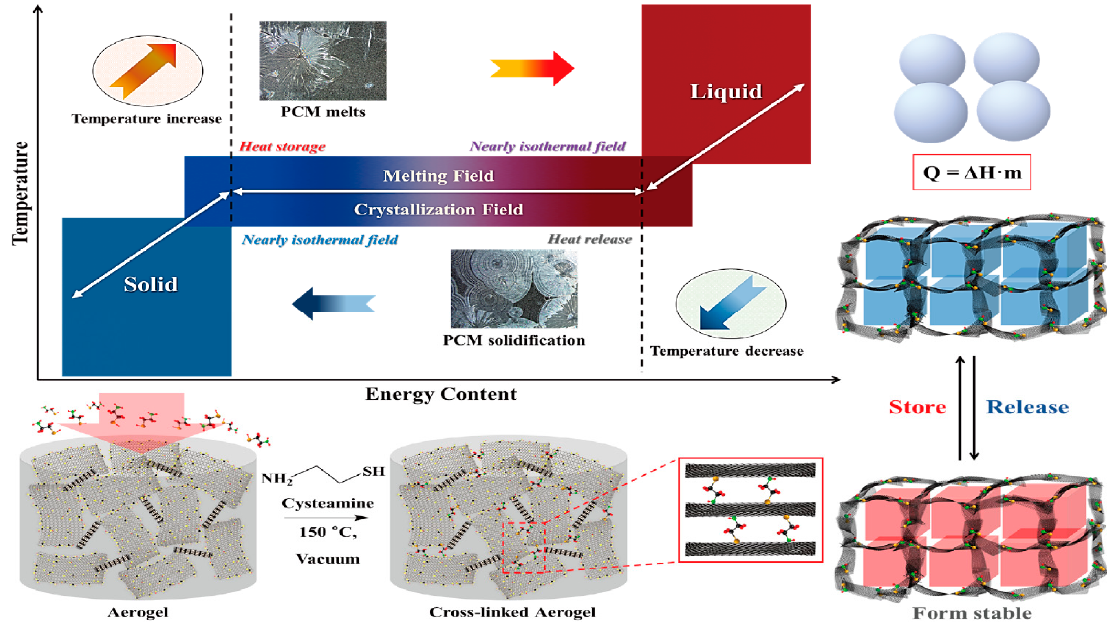
Figure 1. Schematic of PCM for energy storage and fabrication procedure for form stable PCM composite.